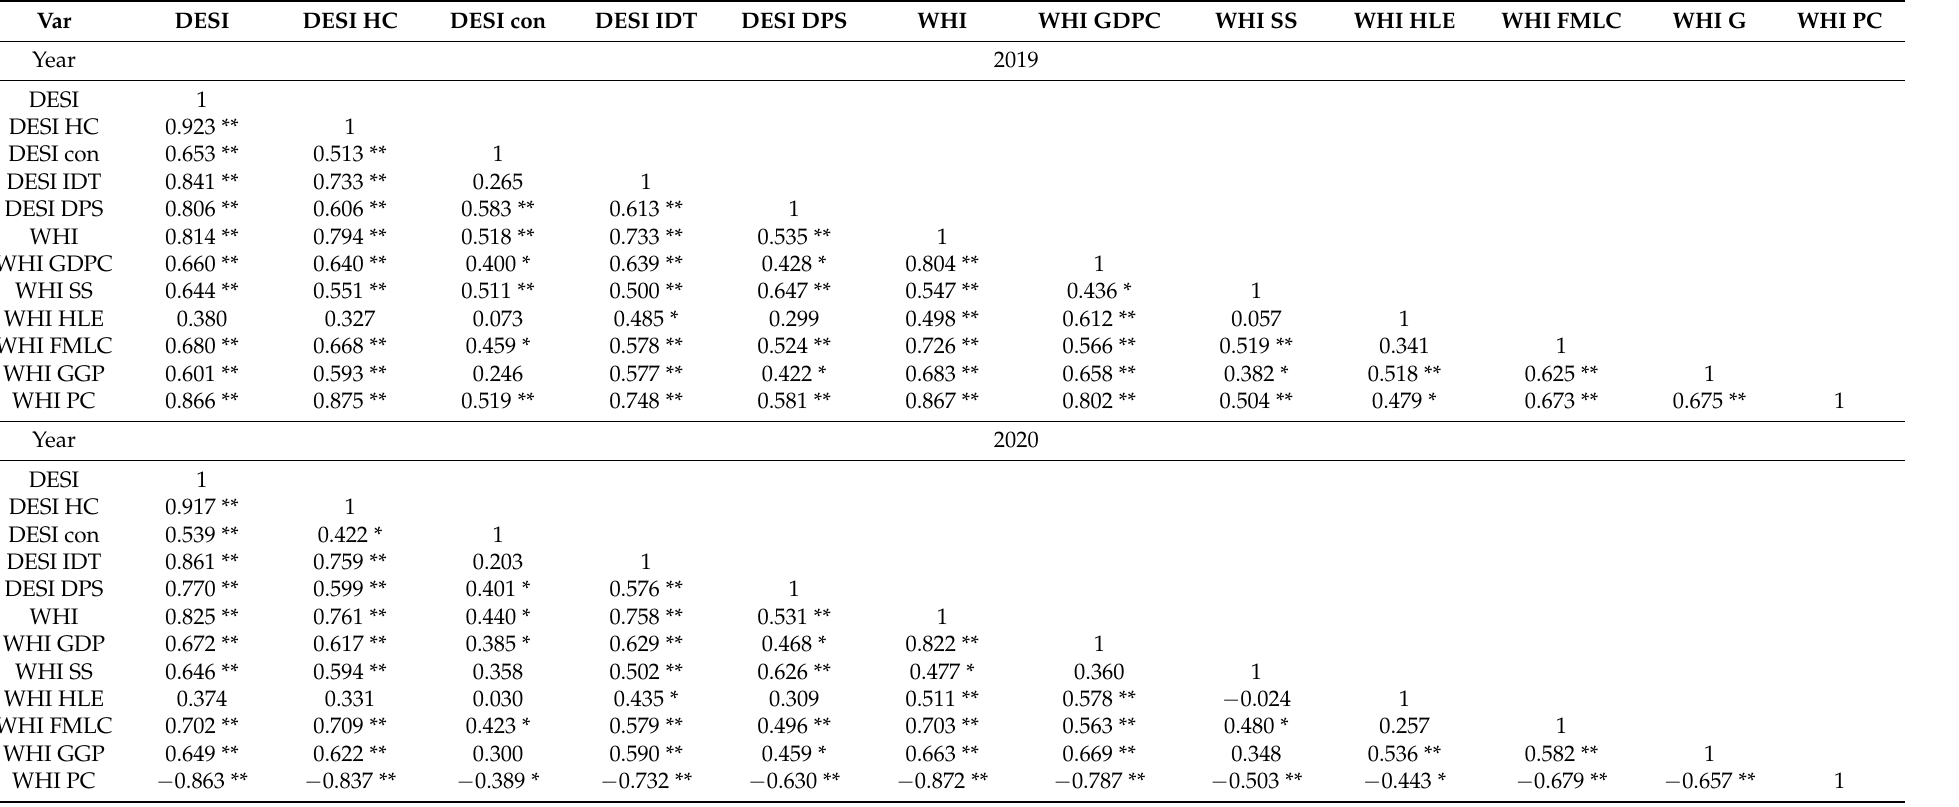
Table 5. Correlations between DESI index and World Happiness